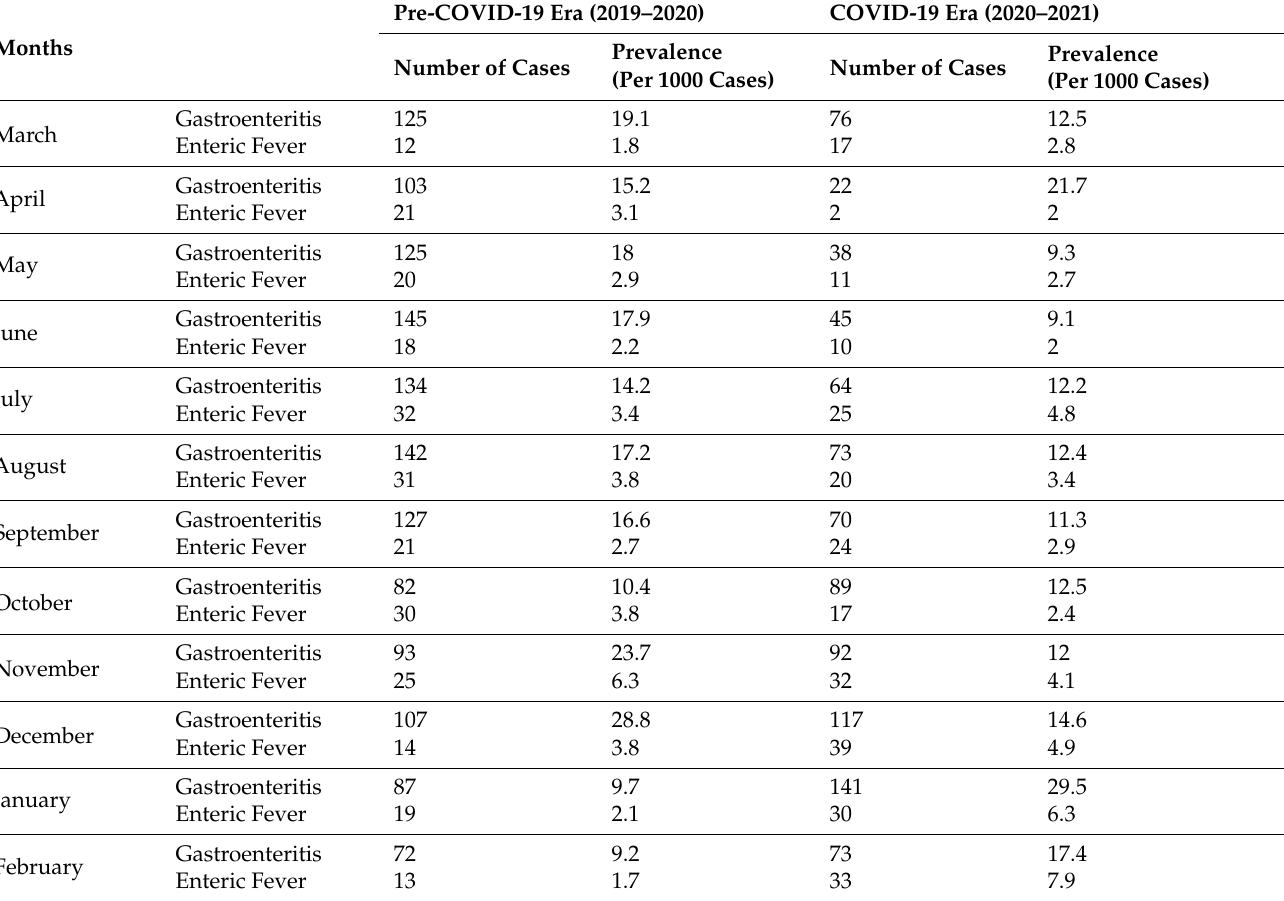
Table 1. Cases of gastroenteritis and enteric fever in the pre-COVID-19 and COVID-19